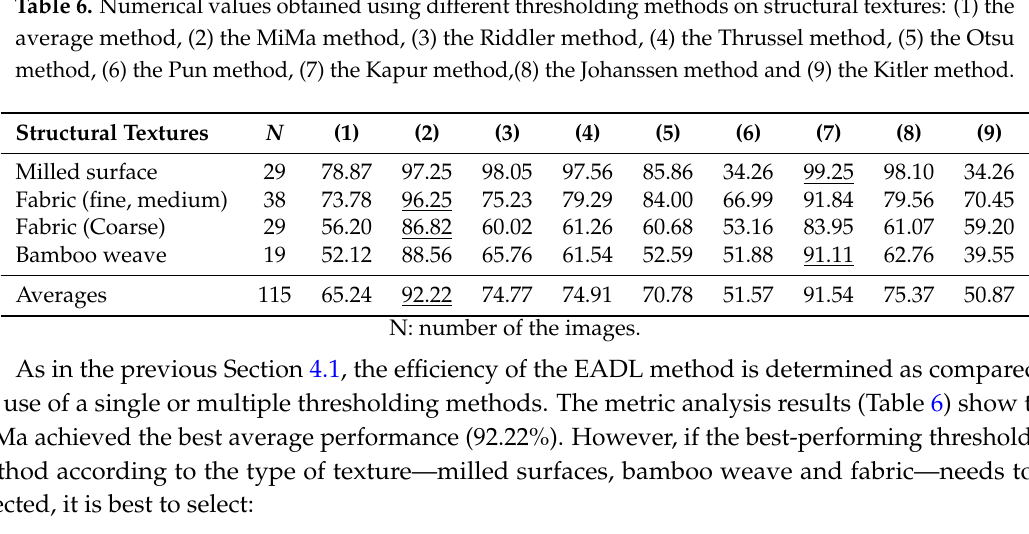
Table 5. J ∗ calculated from structural textures of Figure 11a,f,k,p,u with the EADL method ( r j coefficients are shown), with the automatic band selection method (Tsai [46]) and the adaptive level-selecting method (Han [25]) (For r j , ADR j and J ∗ , see see Equations (7)–(9)). Image in Figure 11 j = 1